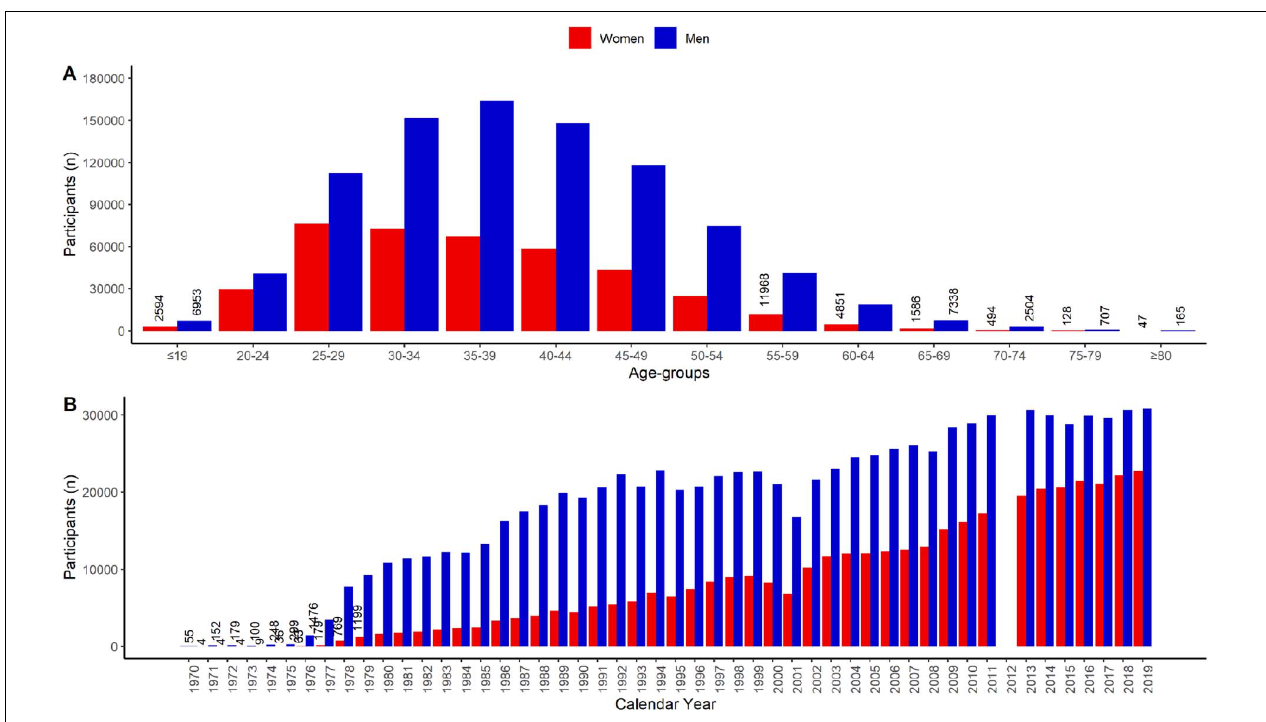
FIGURE 1 | Participants by age group (A) and calendar years (B)